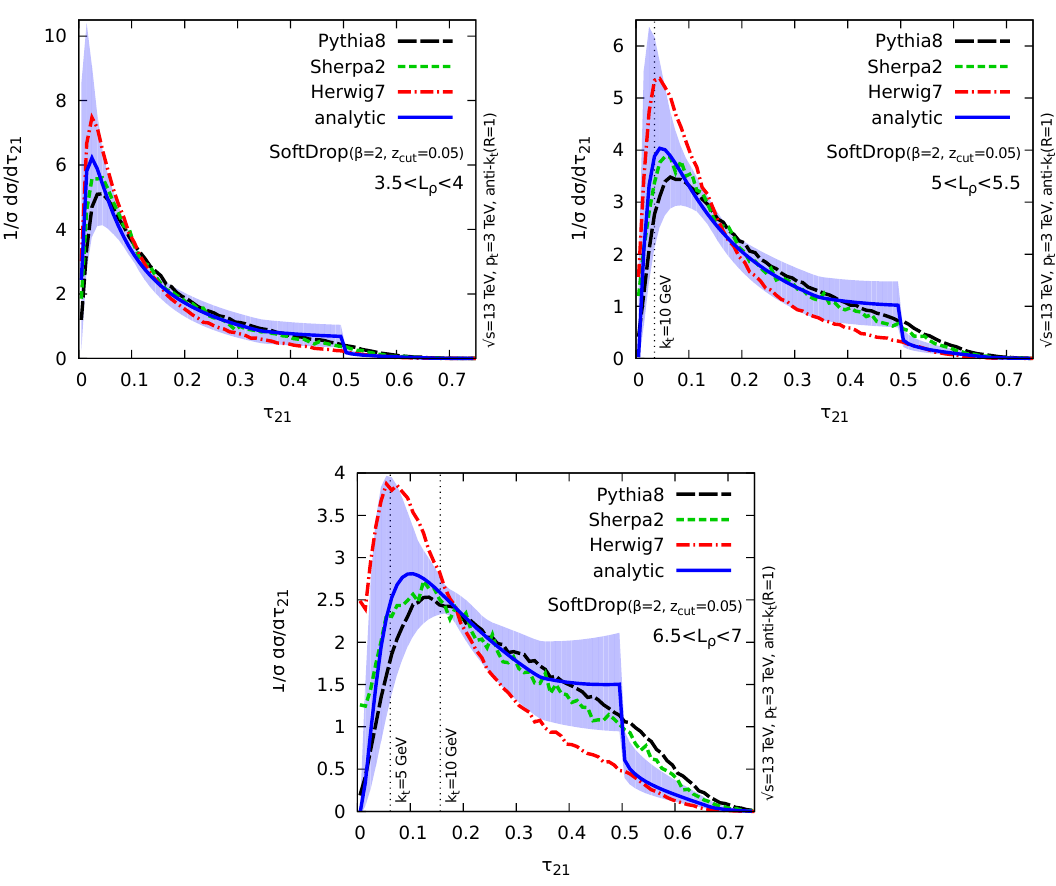
Figure 6 . Di(cid:11)erential distribution in (cid:28) compared to Monte Carlo for 3 di(cid:11)erent bins in L (cid:26) = log(1 =(cid:26) ). We show our analytic results (with their uncertainty band) compared to the Pythia8, Sherpa2 and Herwig7 generators. All results are for jets groomed with SoftDrop. The vertical dashed lines indicate when the scale (cid:26)(cid:28) starts to hit a given k t value, indicative of where non- perturbative e(cid:11)ects are expected to become